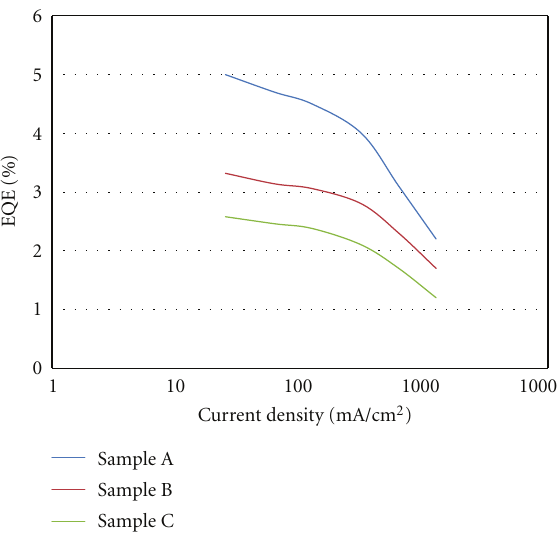
Figure 4: J-EQE characteristics in all RGB-type samples.